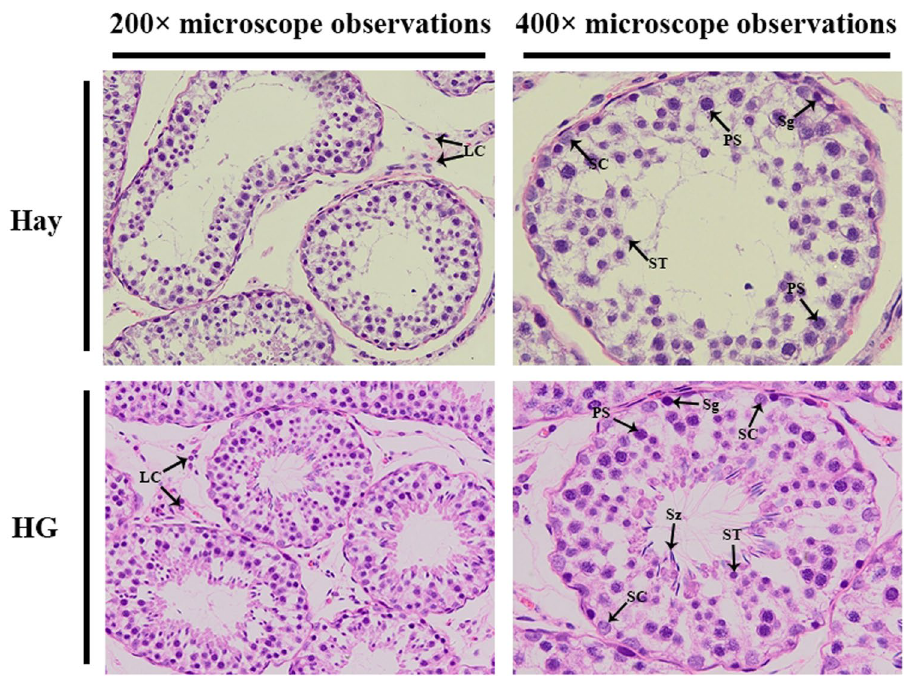
Figure 2. Histologic observations of sheep testes in the hay and HG diet groups. SC, Sertoli cell; LC, Leydig cell; Sg, spermatogonia; PS, primary spermatocyte; ST, spermatid; Sz,